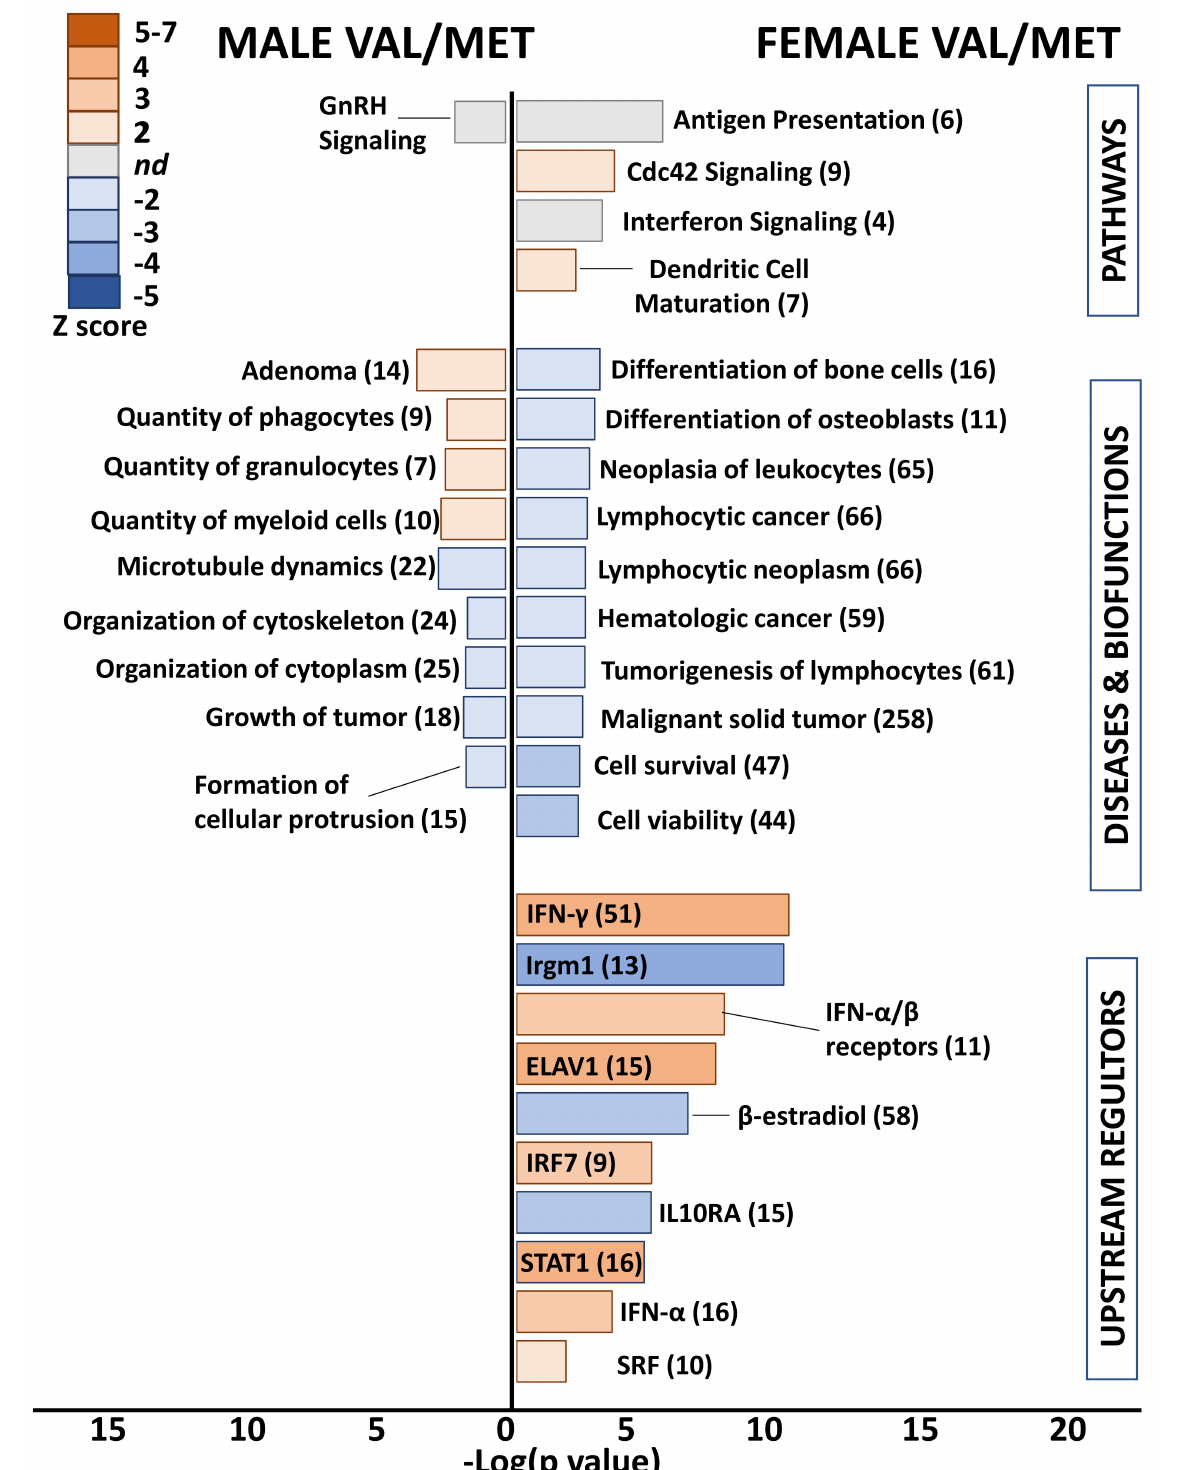
Figure 4. Whole hearts from Val/Met mice exhibit blunted functional profiles loosely related to immune cell proliferation. Bar chart shows enriched pathways ( top bars), diseases and biofunctions ( middle bars), and predicted upstream regulators ( bottom ) for whole hearts of male ( left side) and female ( right side) Val/Met mice compared to normal Val/Val controls. Bar size reflects significance (shown on x axis), and color represents Z score (significance of prediction of directionality), as indicated in the legend. Numbers in parentheses indicate numbers of genes in the listed category that were altered in hearts of either male or female Val/Met mice compared to respective